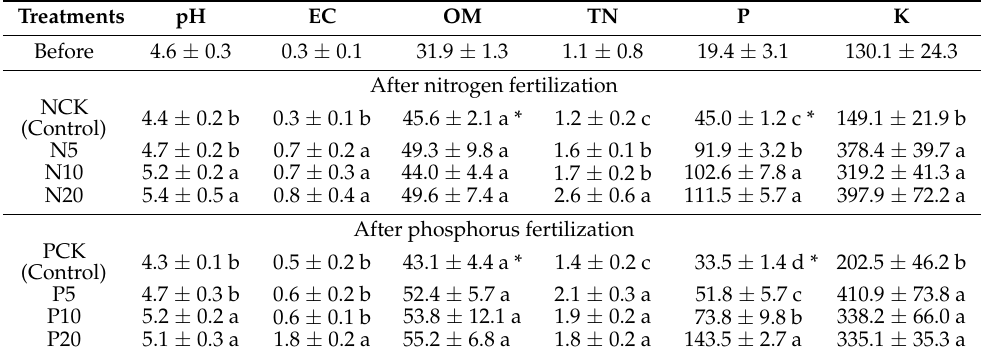
Table 1. Effects of different fertilizer treatments on soil pH, electrical conductivity, organic matter, total nitrogen, phosphorus, and potassium